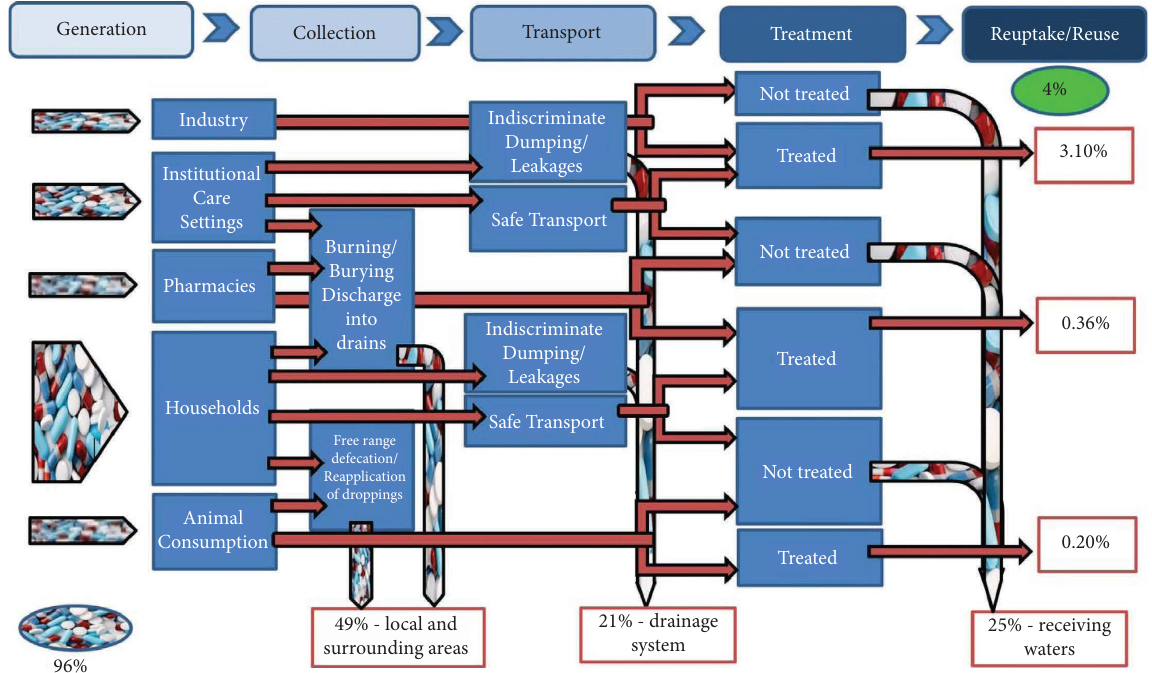
Figure 7: Drug disposal fow diagram showing the likely pathways for disposal of drugs within the Krowor